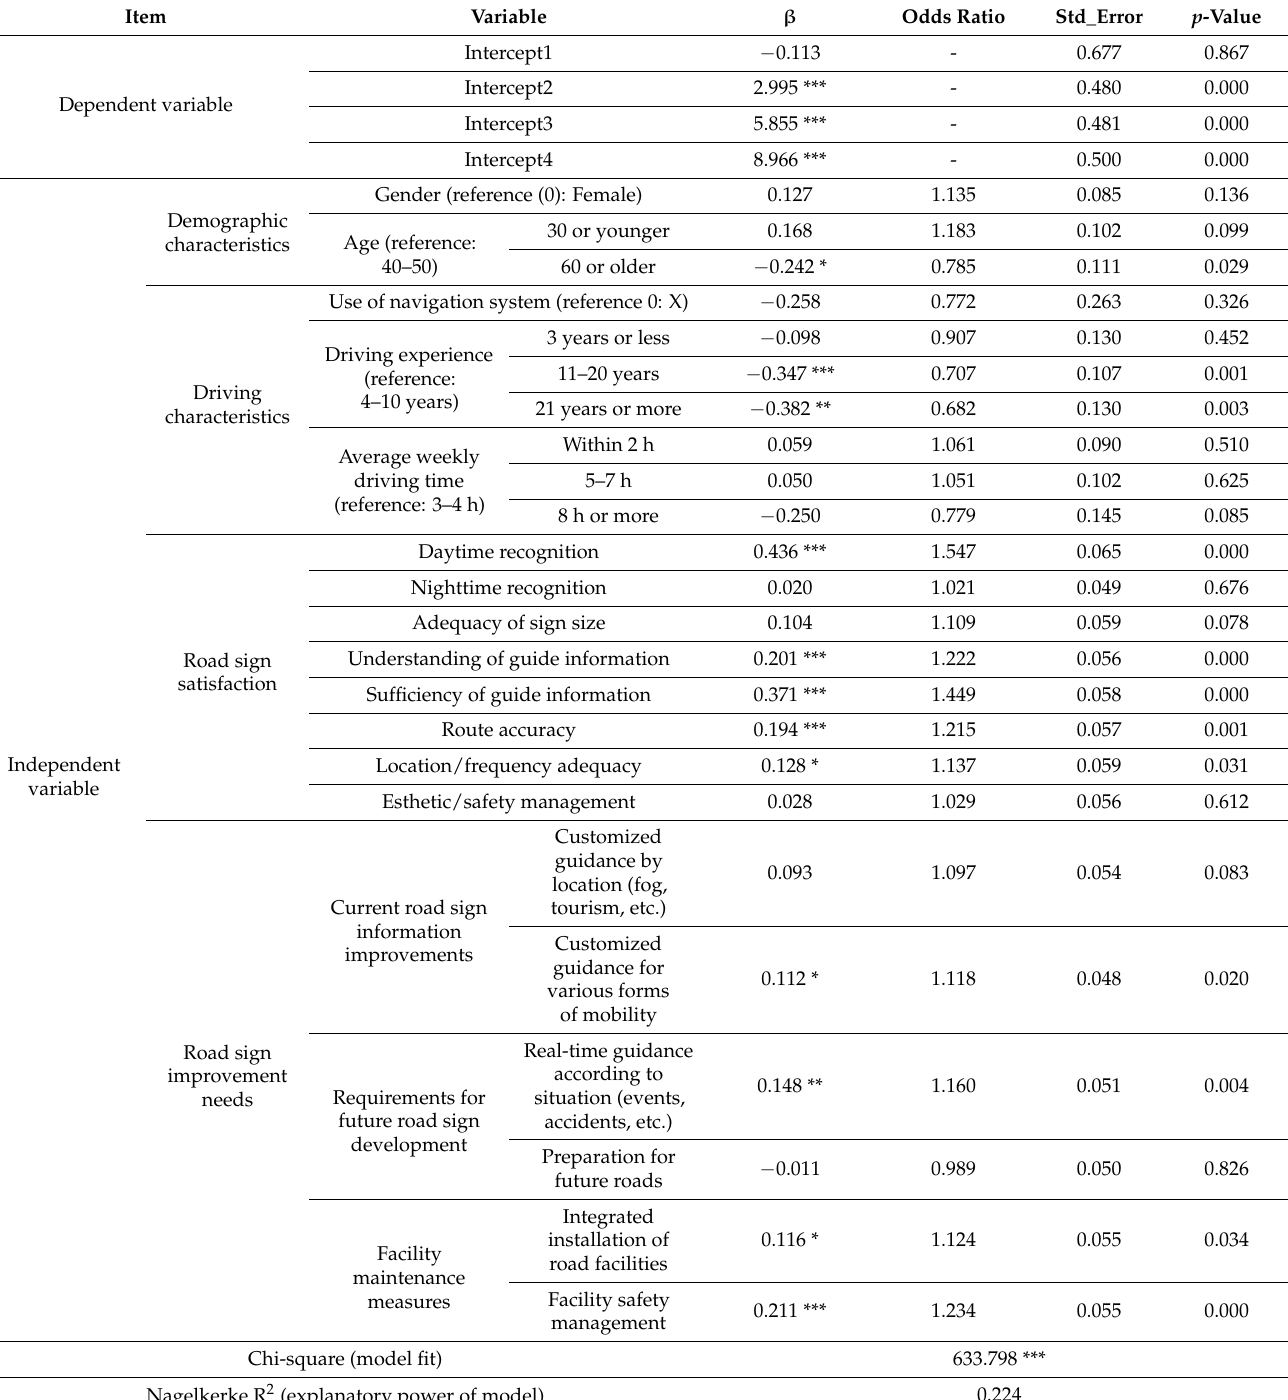
Table 6. Analysis of all